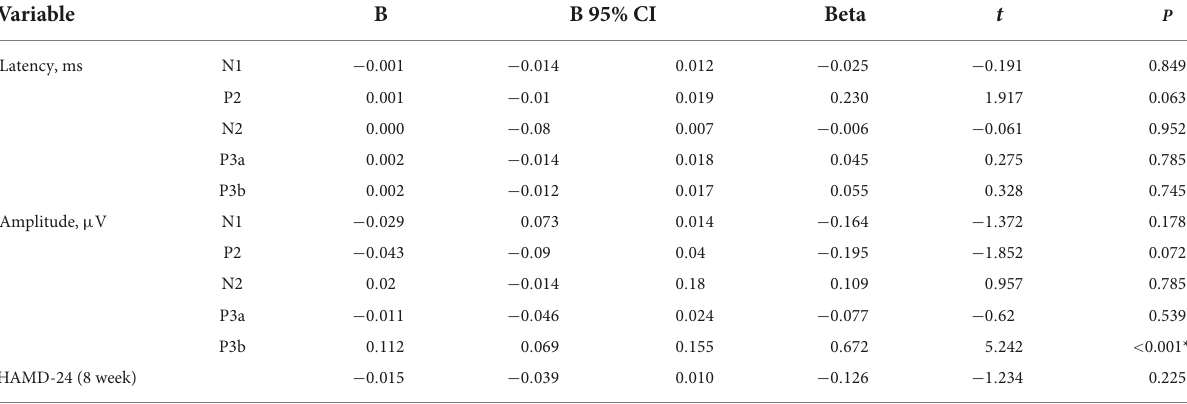
TABLE 4 Regression analysis of the reduction rate of NSSI after 8 weeks of treatment. Variable B B 95% CI Beta t P Latency,